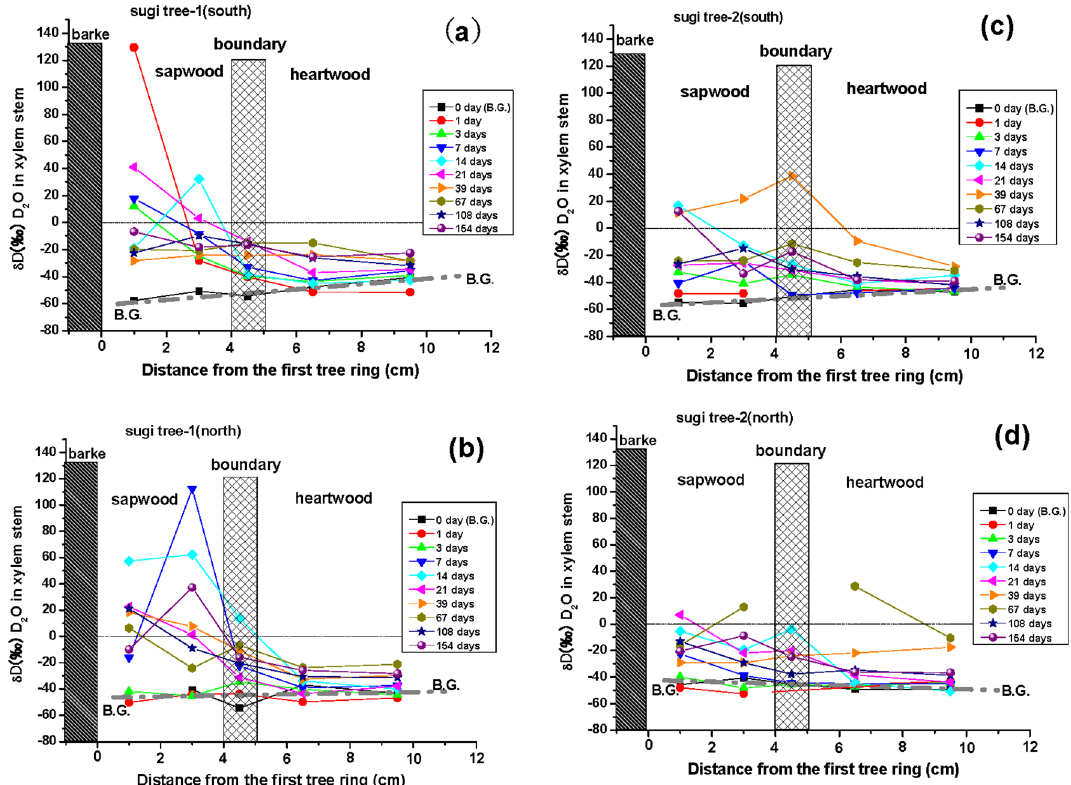
Figure 2. Changes in sap δD values (‰) in sapwood, intermediate wood (the sapwood–heartwood boundary), and heartwood of sugi trees ( n = 2) in the D 2 O tracer test conducted at the Abiko site from 2 July to 2 December 2019. ( a ) South side of sugi tree S1, ( b ) north side of sugi tree S1, ( c ) south side of sugi tree S2, ( d ) north side of sugi tree S2. B.G. is the background level of δD values (‰) in xylem sap collected on 2 July before the tracer test